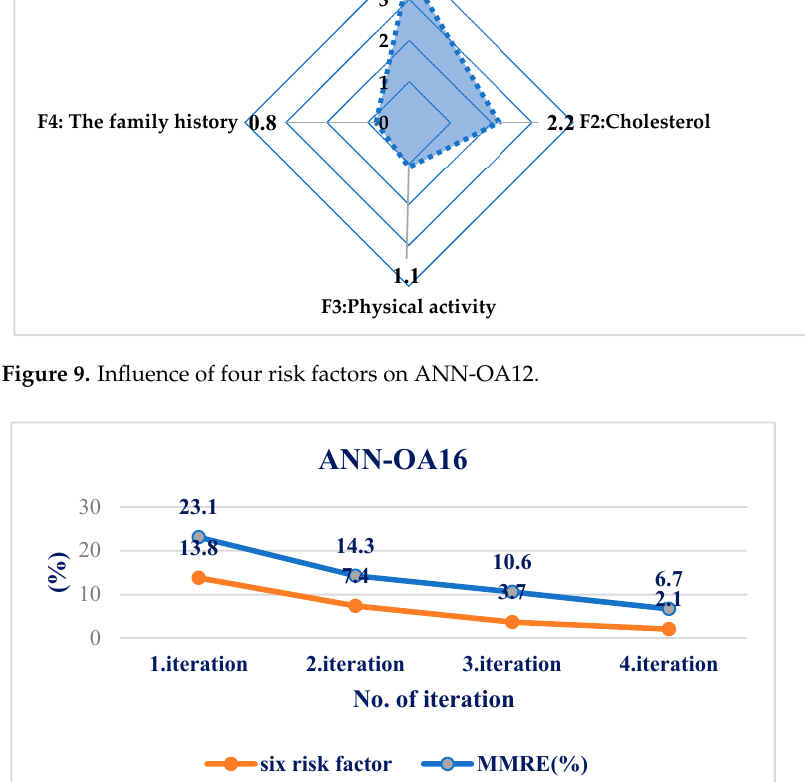
Figure 9. Influence of four risk factors on ANN-OA12.